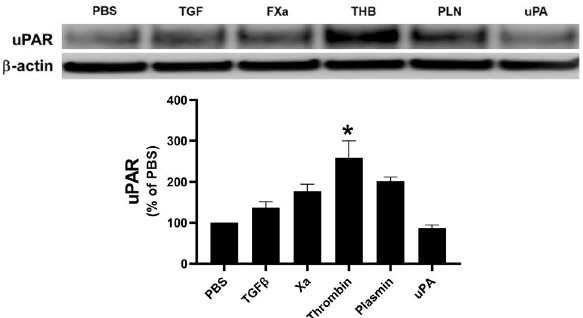
Figure 2. uPAR expression is modulated by mediators of MesoMT. Serum-starved HPMCs were treated with PBS, TGF-β (5 ng/ml), FXa (Xa, 13 nM), thrombin (THB, 7 nM), plasmin (PLN, 7 nM), and uPA (20 nM) for 48 h. uPAR expression was then determined by western blotting. β-actin was used as the loading control. TGF- β, FXa, thrombin and plasmin treated cells demonstrated increased uPAR expression. Image is representative of three independent experiments. Graphed densitometric analysis represents n =